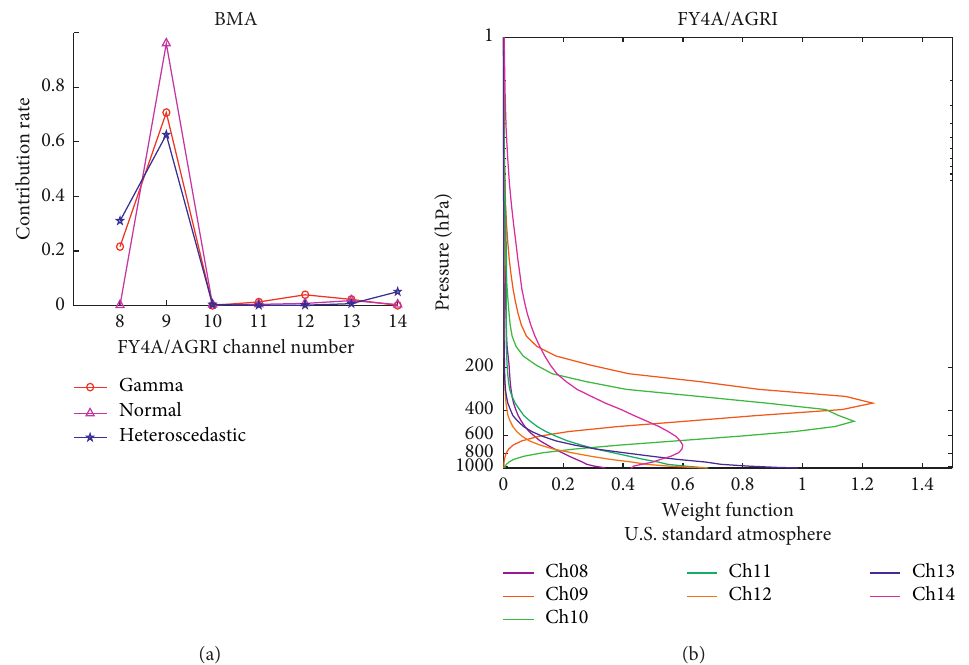
Figure 2: Contribution rate of AGRI channel brightness temperature optimization based on the BMA method (a) and the weight function distribution of AGRI channels 8 to 14